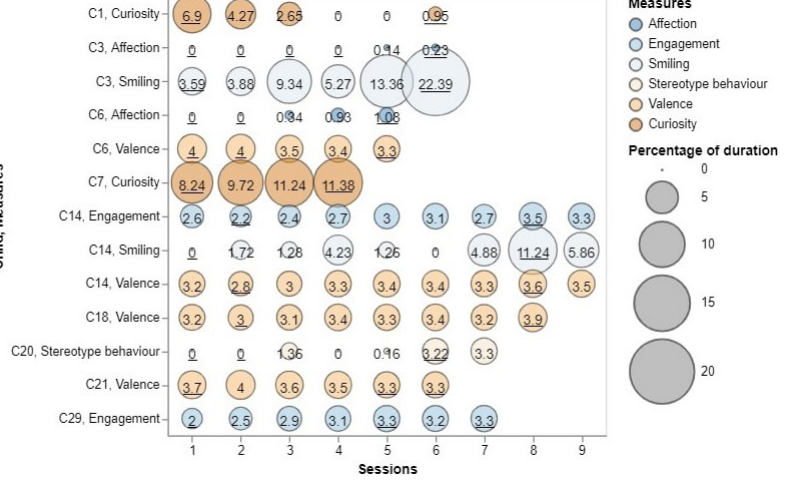
Figure 2. The significant differences of individual analyses over sessions. n for p <